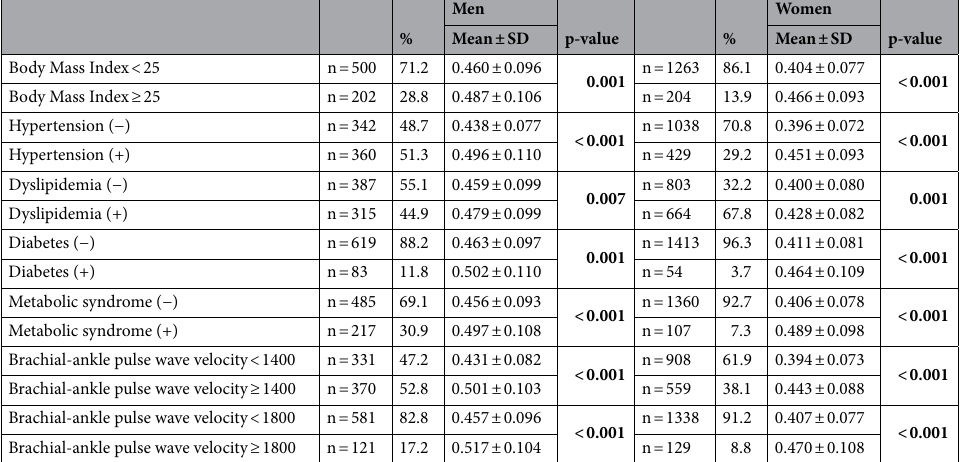
Table 2. The means of mid-regional pro-adrenomedullin according to cardiometabolic disease and brachial- ankle pulse wave velocity. Category differences are analyzed by Welch’s t-tests. Bold style represents p <